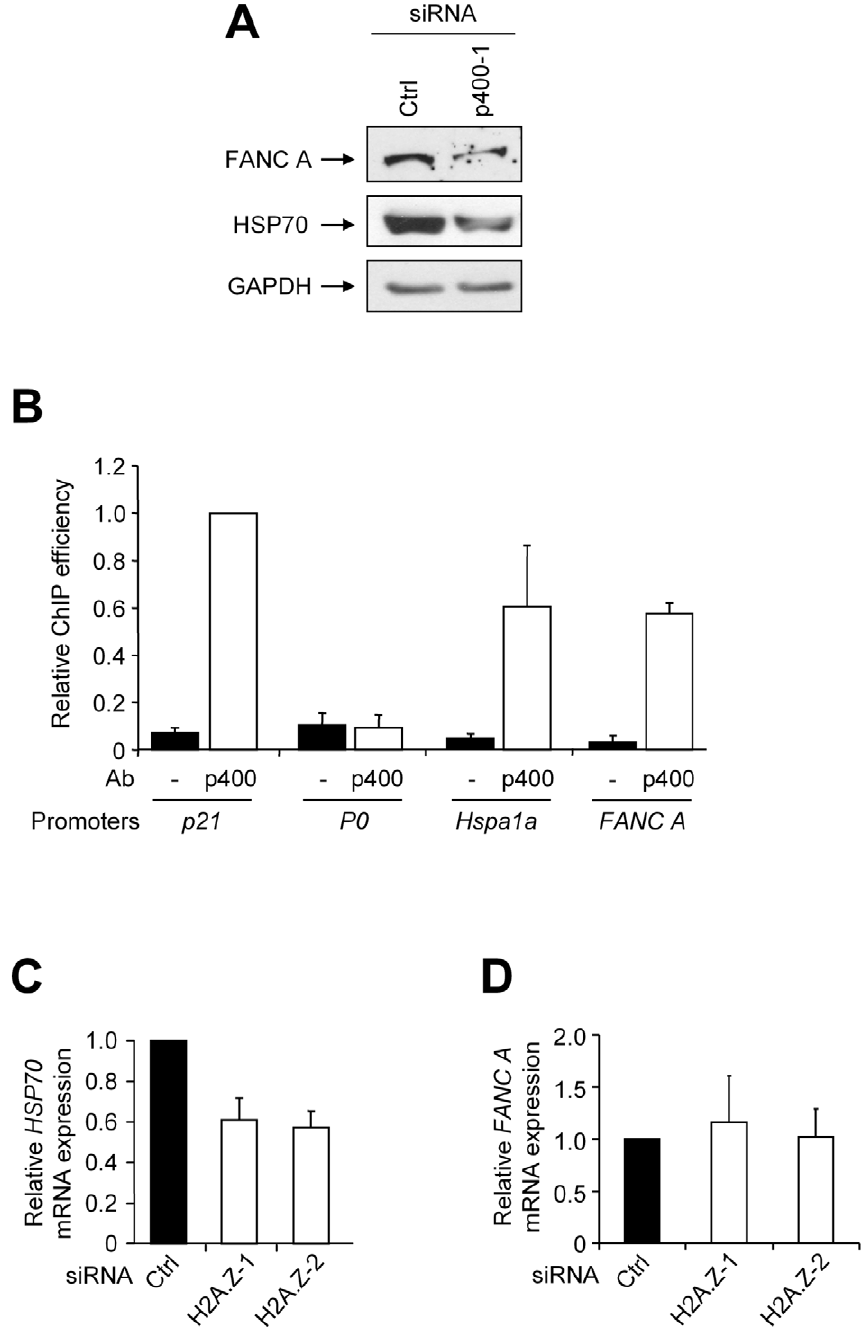
Figure 7. Hsp70 and FANCA are direct target genes of p400. (A) U2OS cells were transfected using the indicated siRNA. 48 h following transfection, total cell extracts were prepared and analysed by western blot using anti-FANCA, anti-Hsp70 and anti-GAPDH (as a loading control) antibodies. (B) U2OS cells were subjected to a ChIP experiment using p400 antibodies or without antibody as indicated. The amounts of p21, Phosphoprotein P0 , Hspa1a and FANCA promoters in the immunoprecipitates and in the inputs were measured by Q-PCR. ChIP efficiency (% of input DNA) was calculated relative to 1 for the amount of p21 promoter immunoprecipitated by the p400 antibody. The mean and SD from three independent experiments are plotted. (C) U2OS cells were transfected using the indicated siRNA. 48 h following transfection, cells were harvested and total RNA was prepared and reverse transcribed. cDNAs were then analysed for Hsp70 and GAPDH expression by Q-PCR. The amount of Hsp70 cDNA was divided by the amount of GAPDH cDNA and calculated relative to 1 for cells transfected using the control siRNA. The mean and SD from three independent experiments are shown. (D) Same as in (C) except that cDNA were analysed for FANCA and GAPDH expression.